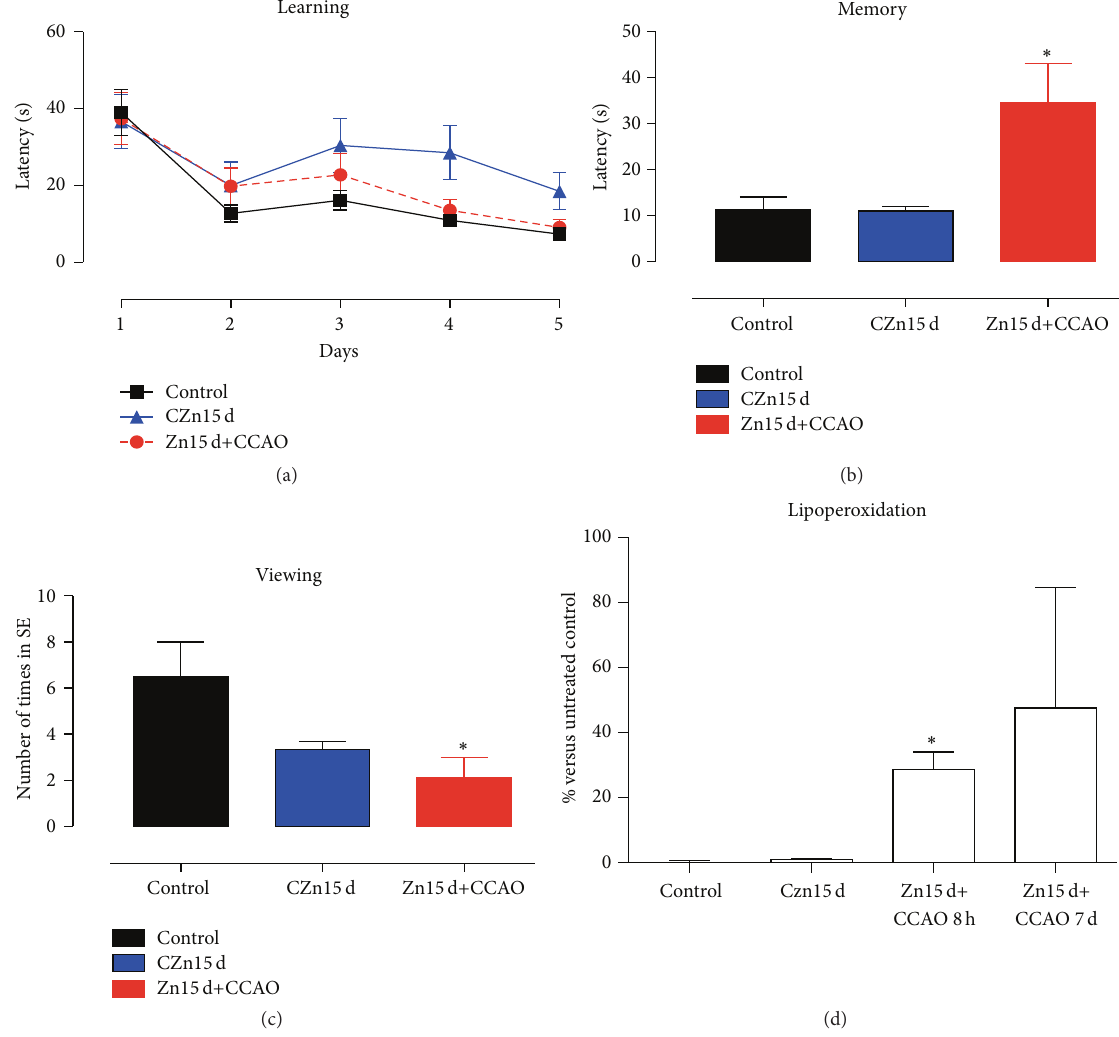
Figure 6: Effect of chronic administration of zinc on learning and long-term memory after hypoxia-ischemia in rats. (a) Graph showing the time course of the latency to reach the escape platform expressed as the mean value of four events of a daily evaluation per rat in the Morris water maze ( 𝑛 = 10 rats per group). Graphs showing the long-term memory latency (b) and the number of platform position crossings determined on day 7 after the training, that is, on day 12 after reperfusion (c) ( 𝑛 = 5 rats per group). The values are the mean ± SEM. ∗ Significant when compared with the control group; unpaired Student’s 𝑡 -test; 𝑃 < 0.05